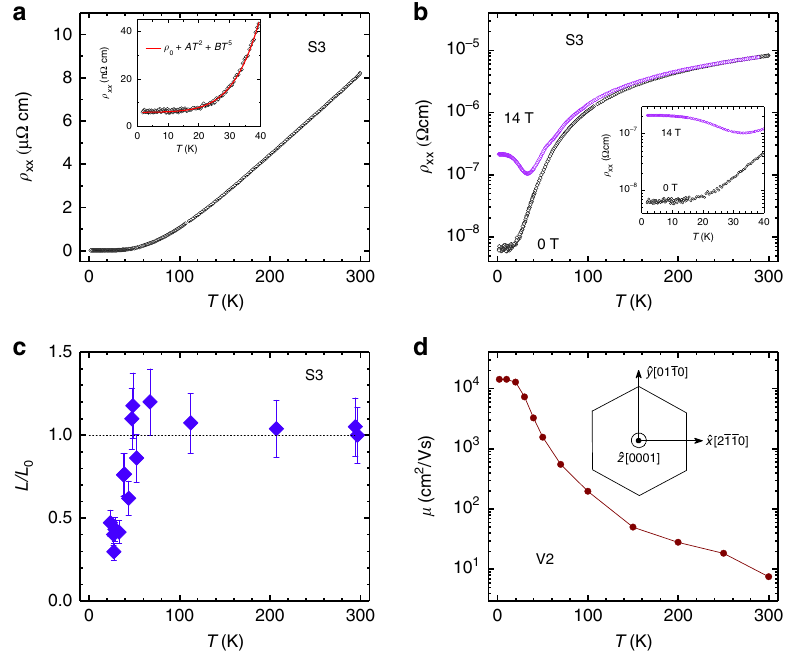
Fig. 2 Resistivity, Lorenz number and mobility of MoP. a Temperature dependent resistivity, ρ xx for I jj ^ x . The inset shows the best fi t with ρ xx = ρ 0 + AT 2 + BT 5 for the region T < 40 K, where the values of ρ A and B are 6.0 × 10 − 9 Ω cm, 2.3 × 10 − 12 Ω cmK − 2 and 3.6 × 10 − 16 Ω cmK − 5 , respectively. 0 , b Temperature dependent ρ xx at 0 and 14 T when I jj ^ x and B jj ^ z . The inset shows a signi fi cant magnetoresistance below 40 K. c Temperature dependent normalized Lorenz number, L / L 0 , where L 0 is the Lorenz number. The error bar comes from the error in the thermal conductivity measurement (See Supplementary Fig. 7). A strong violation of the Wiedemann – Franz law is observed below 40 K. d Temperature dependent charge-carrier mobility, μ , of MoP. The inset of d shows the crystallographic directions in the hexagonal representation in which ^ x , ^ y and ^ z are de fi ned as ½ 2 (cid:1) 1 (cid:1) 10 (cid:2) , ½ 01 (cid:1) 10 (cid:2) and